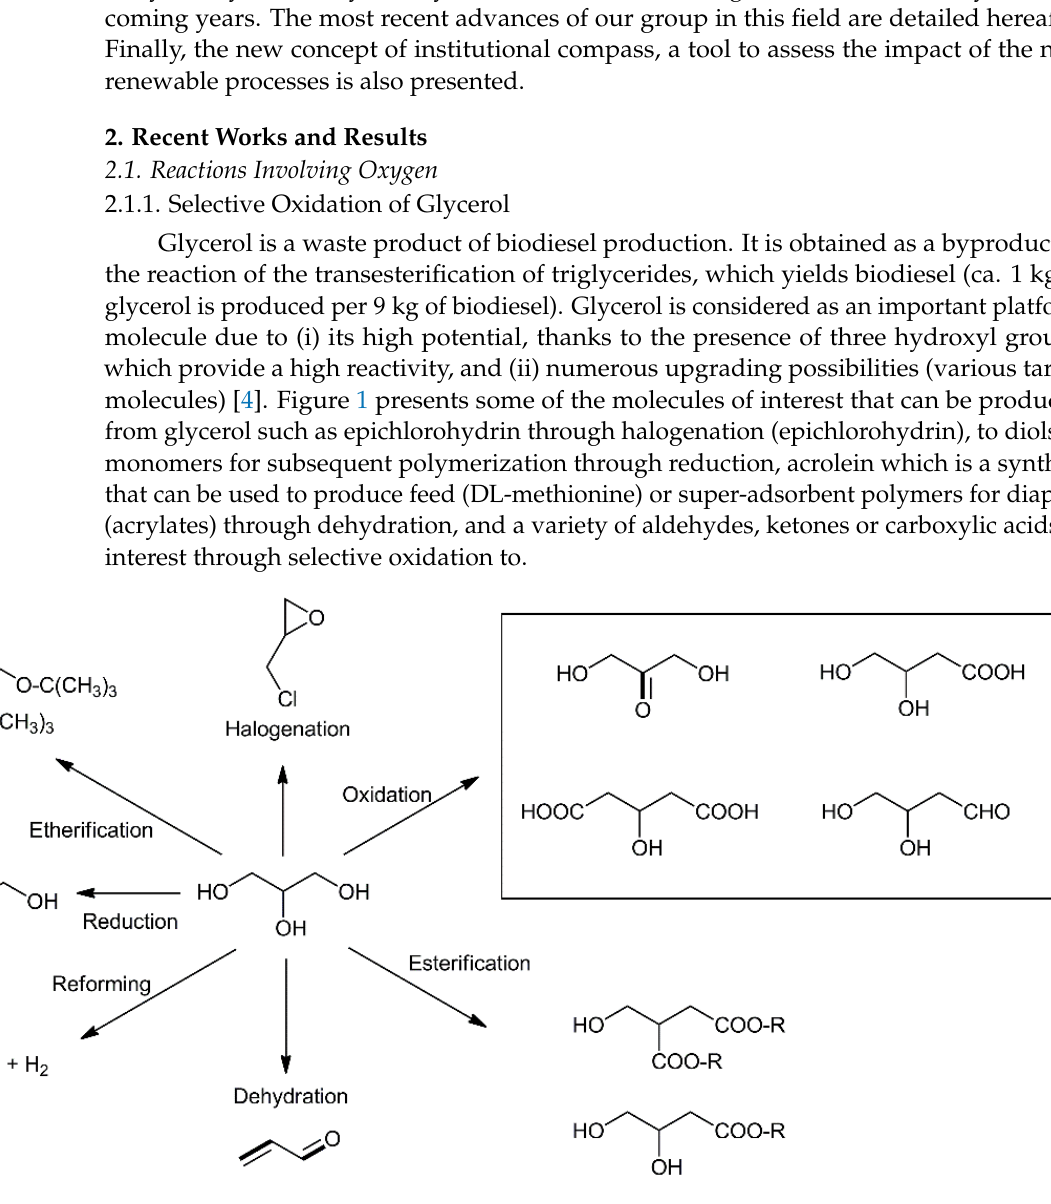
Figure 1. Examples of molecules of interest obtained through upgrading glycerol.